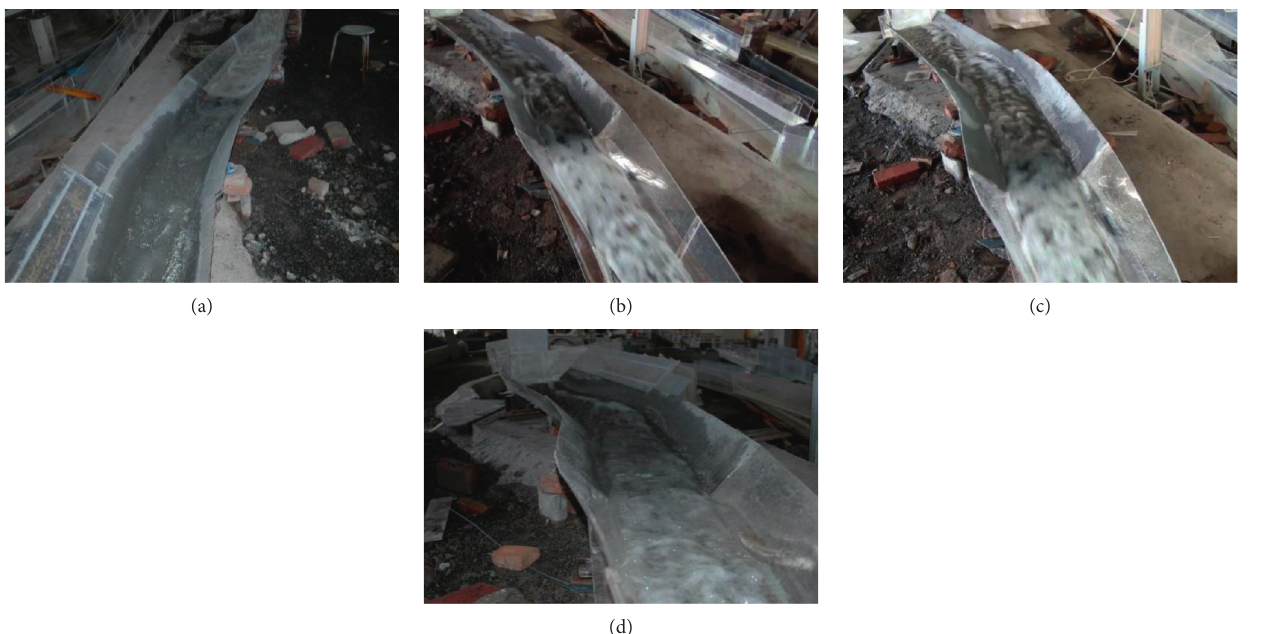
Figure 9: Flow regime at the tail channel section under different conditions in the improved scheme. (a) Flow state under a 10-year flood.